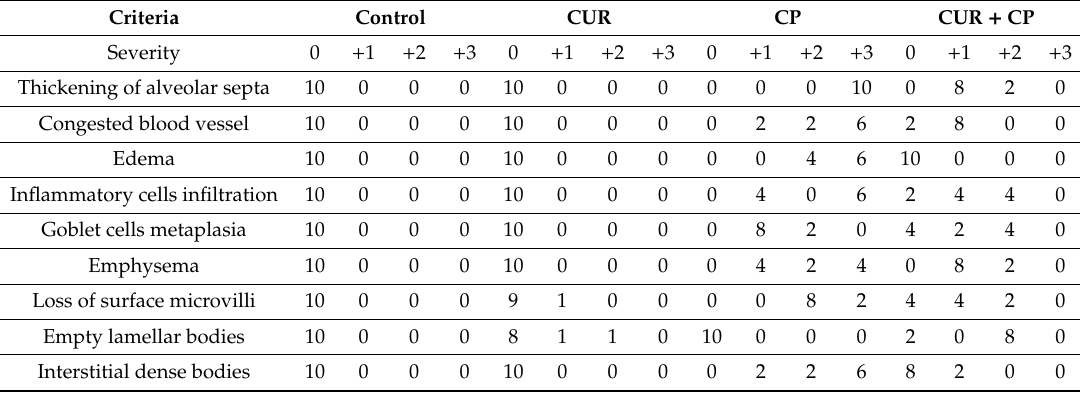
Table 1. Lesion severity grading of the 10 fields of lung sections.